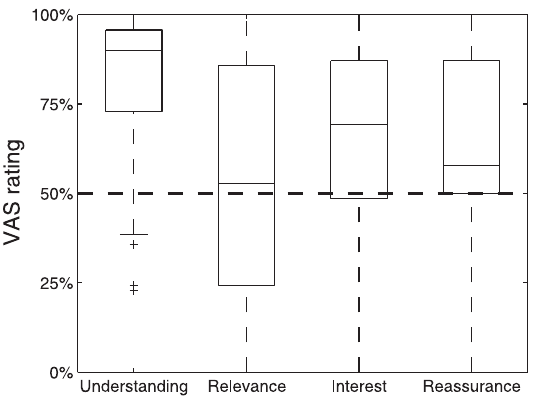
Figure 1. Perception of the information provided by the OLAP tool. Boxplots represent ratings on a VAS normalized to 0% to 100% with 50% representing a neutral rating. Extreme poles with pairs of adjectives are labeled to assess understanding (no understanding vs. complete understanding), relevance (not relevant vs. highly relevant), interest (not interesting vs. highly interesting), and threat (threatening vs. reassuring). Data as median and quartiles, outliers represented by plus signs.